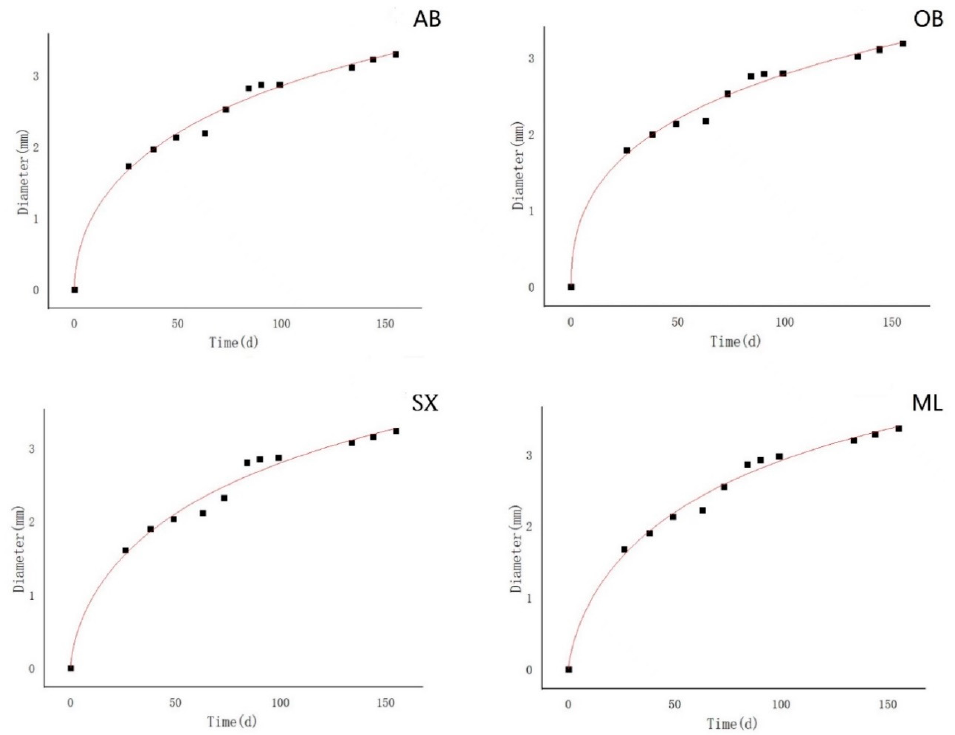
Figure 4. Logistic fitting curves of seedling diameter of X. sorbifolium from different provenances.